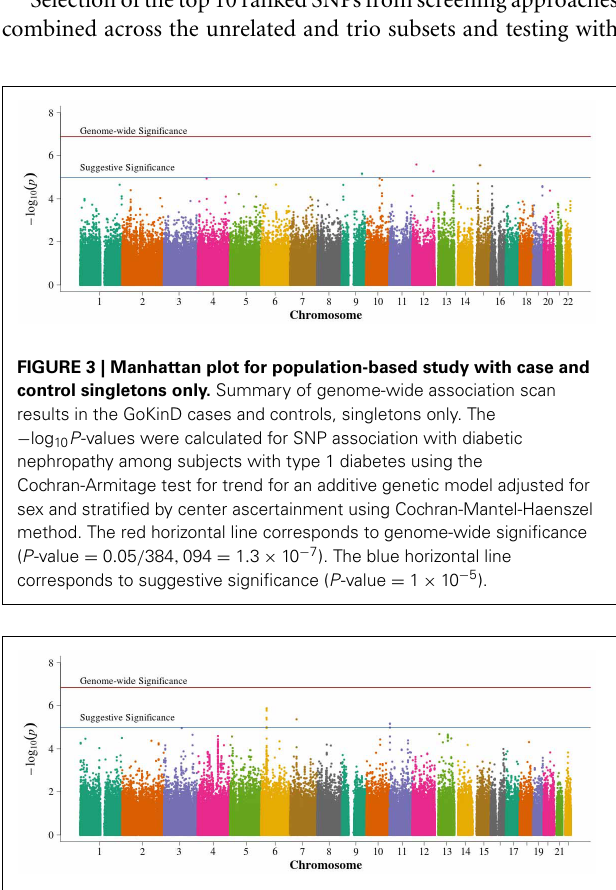
FIGURE 4 | Manhattan plot for family-based study. Summary of genome-wide association scan results in the GoKinD cases and controls family-based trios and duo parent/offspring pairs. The − log 10 P -values were calculated for SNP association with diabetic nephropathy among subjects with type 1 diabetes using the generalized FBAT method with an offset of 0.3 (the prevalence of diabetic nephropathy in type 1 diabetics). The red horizontal line corresponds to genome-wide significance ( P -value = 0.05/351,951 = 1.4 × 10 − 7 ). The blue horizontal line corresponds to suggestive significance ( P -value = 1 × 10 − 5